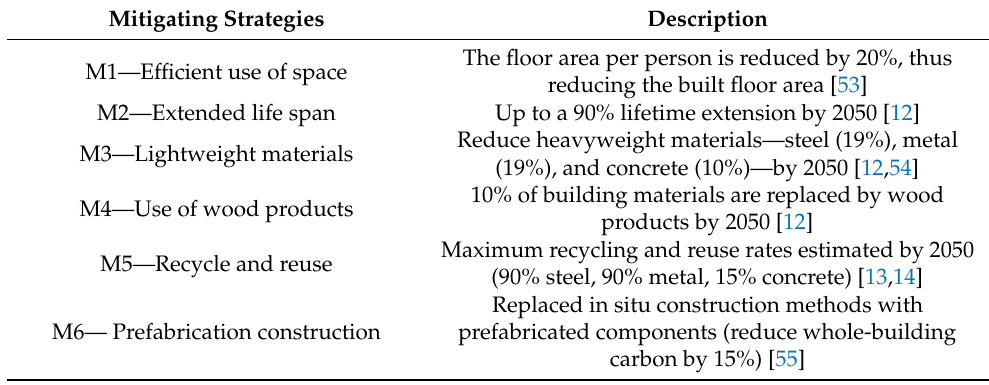
Table 4. Mitigation strategies for reducing embodied carbon emissions from the building stock.